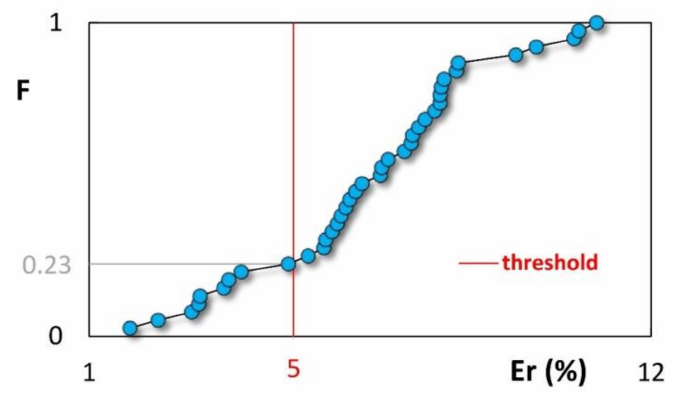
Figure 5. Cumulative frequency distribution of the relative errors, Er (%), of the fitting of the functional relationship (i.e., Equation (14)) for the CL method to the experimental data. Er values not exceeding 5% denote a satisfactory fitting ability of the infiltration model to the data